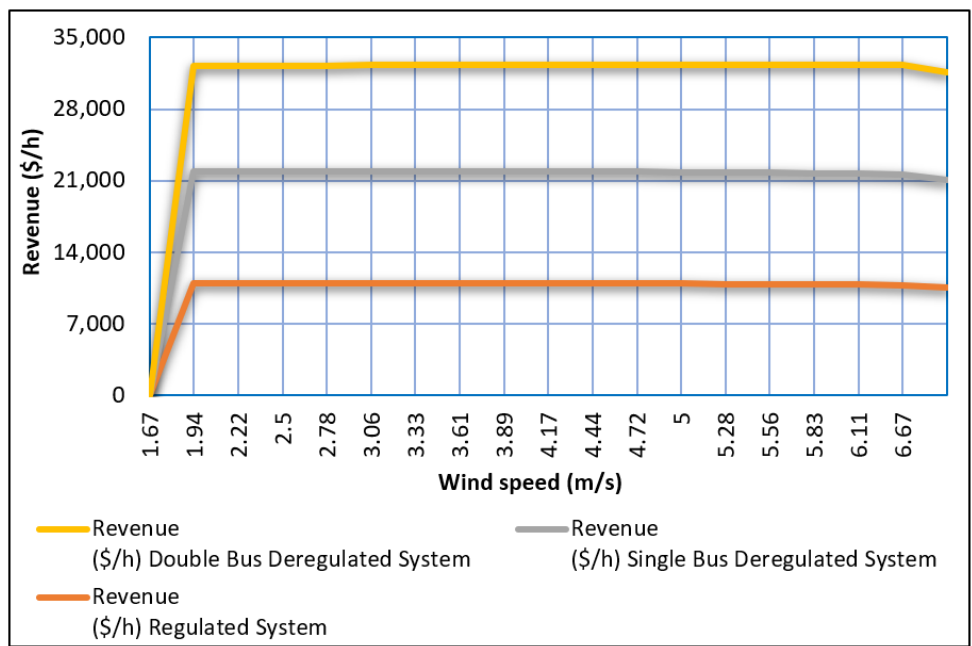
Figure 10. Revenue for regulated and deregulated systems after the placement of a wind generator.